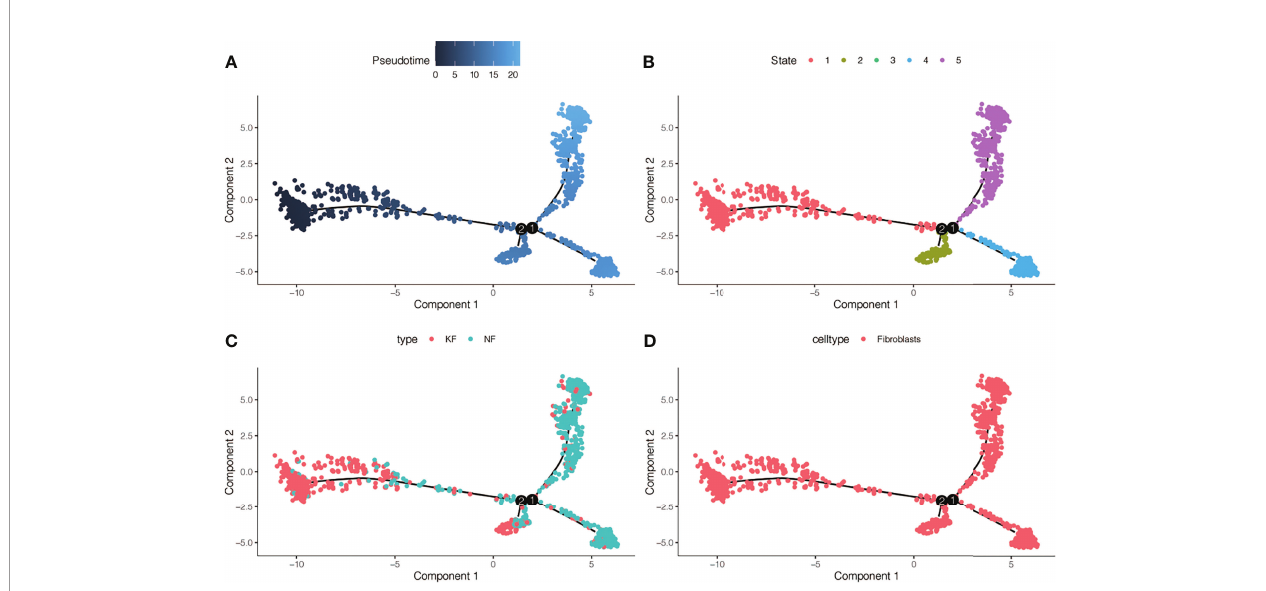
FIGURE 3 | Pseudotime analysis in GSE163973. (A) Differences in the time sequence of cell differentiation. Darker blue indicates earlier differentiation, and lighter blue indicates later differentiation. This provides reference for subsequent analysis. (B) Five differentiation states of fi broblasts. The differentiation of State 1 is the earliest. (C) Differences in differentiation between keloid fi broblasts (KF) and normal fi broblasts (NF). (D) All cells analyzed were fi